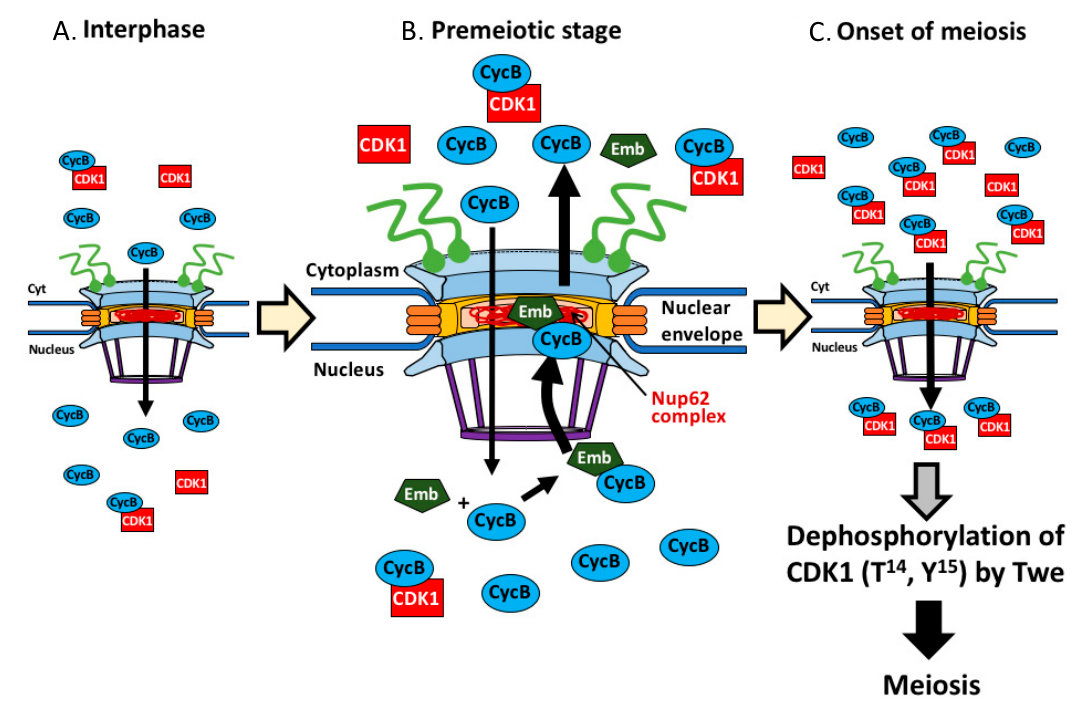
Figure 9. Model showing regulation of initiation of meiosis I by nuclear export of CycB, mediated by the Nup62 complex of NPC and Emb in Drosophila male. CycB was temporally entered the nucleus at interphase (growth phase of spermatocyte) ( A ), associates with Emb, and the protein complex is transported back to the cytoplasm via the central channel in the NPC at premeiotic stage before meiosis ( B ). This requires interaction with the Nup62 complex. Owing to this protein export, sufficient amount of the CycB-CDK1 complex is formed in the cytoplasm. Subsequently, the complex is imported to the nucleus again to remove phospho groups of the CDK1 at T 14 and Y 15 by Twe ( C ). At the end, the active kinase complex in the nucleus triggers meiosis I in Drosophila male.